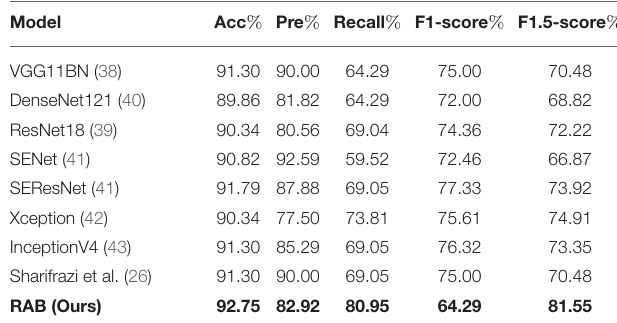
TABLE 2 | Results of severity assessment in COVID-19 patients in terms of Accuracy (Acc), Precision (Pre), recall, and F-score.